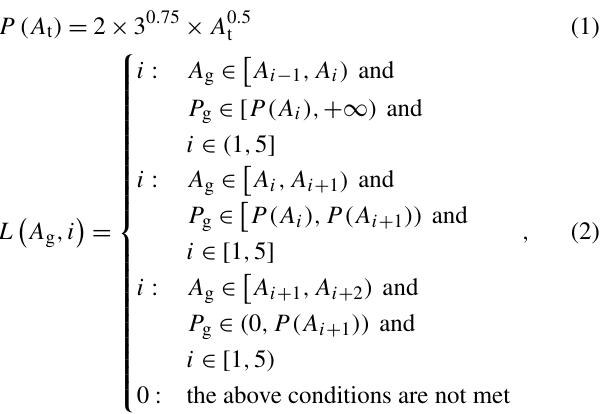
parameter is given in Table